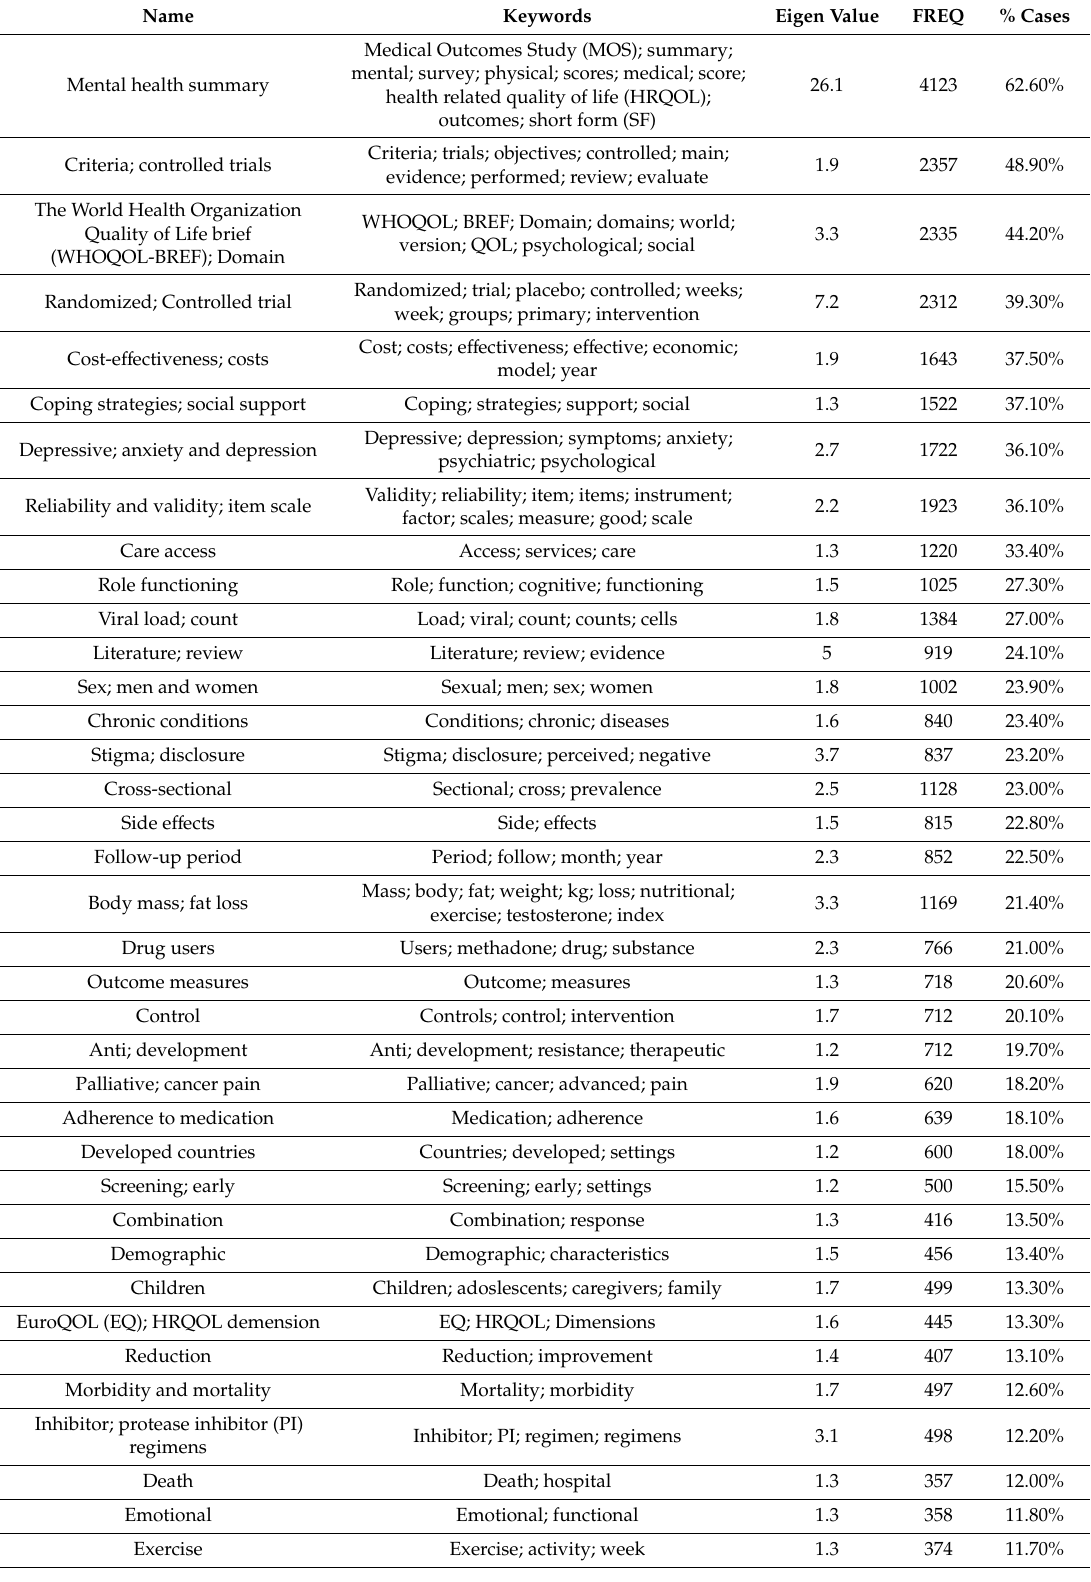
Table 3. Top 50 research domains emerged from exploratory factor analysis of all abstracts’